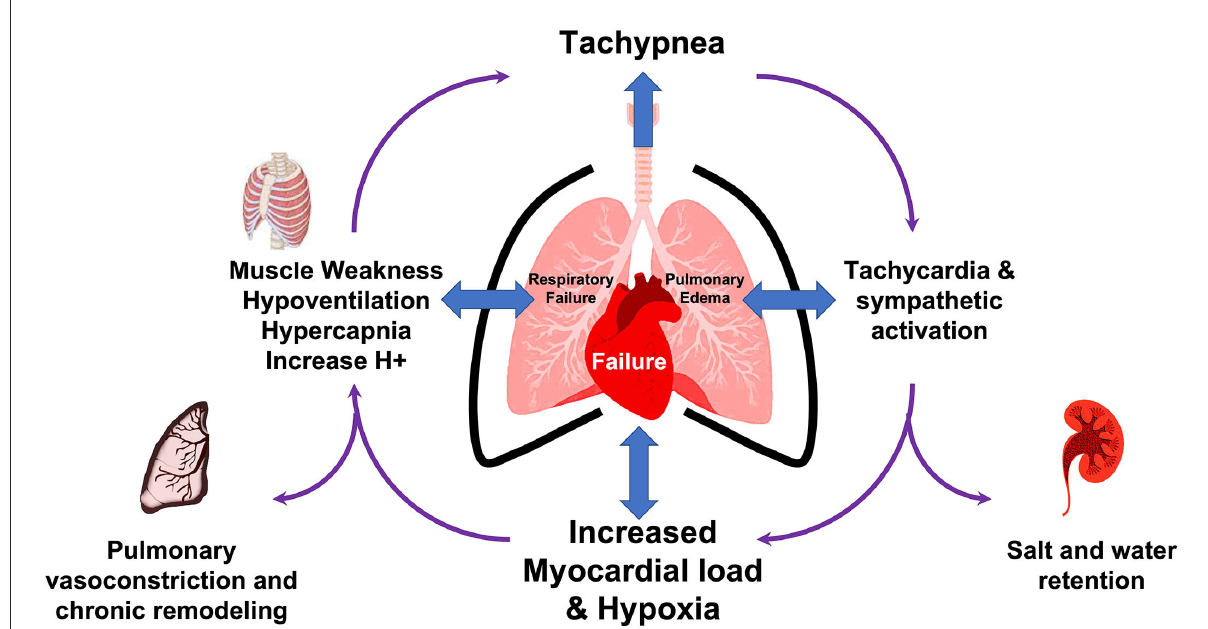
FIGURE4 Summary of mechanisms of disruption of cardiopulmonary coupling in the illustrative